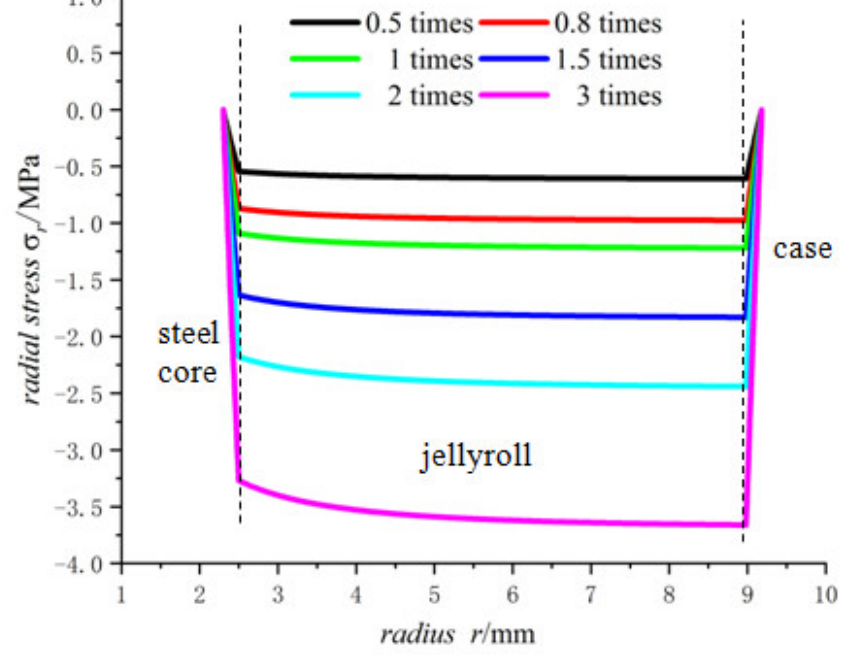
Figure 11. Radial stresses of 18650 battery at different lithium-ion concentrations.